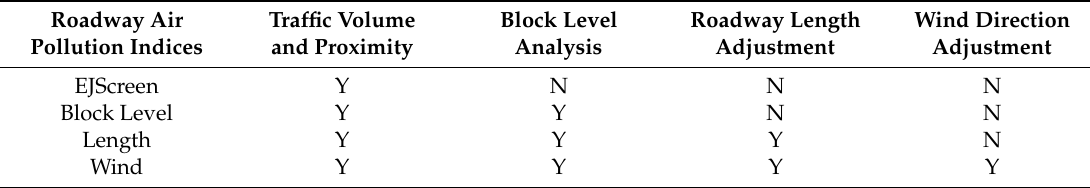
Table 1. EJScreen method and three